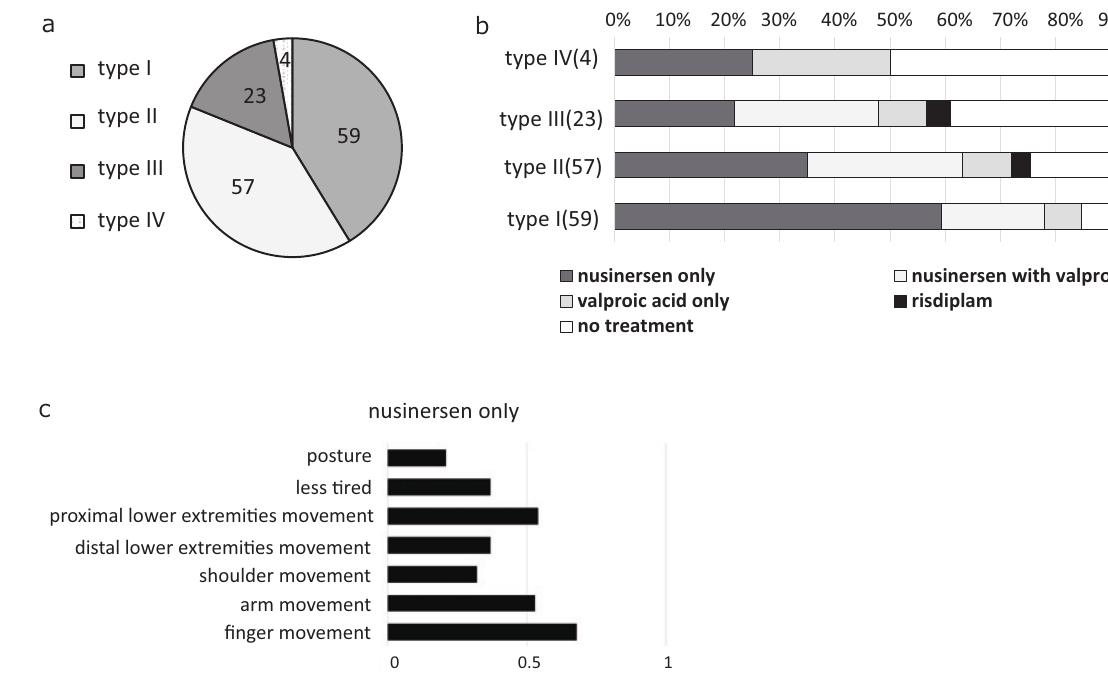
F i g ure 4. Q u estionnaire on therape u tic dr ug s. a ( u pper left) : N u mber of respondents b y clinical t y pe. b ( u pper ri g ht) : P resence, absence, and t y pes of therape u tic dr ug s. c (lo w er) : Each effect of therape u tic dr ug